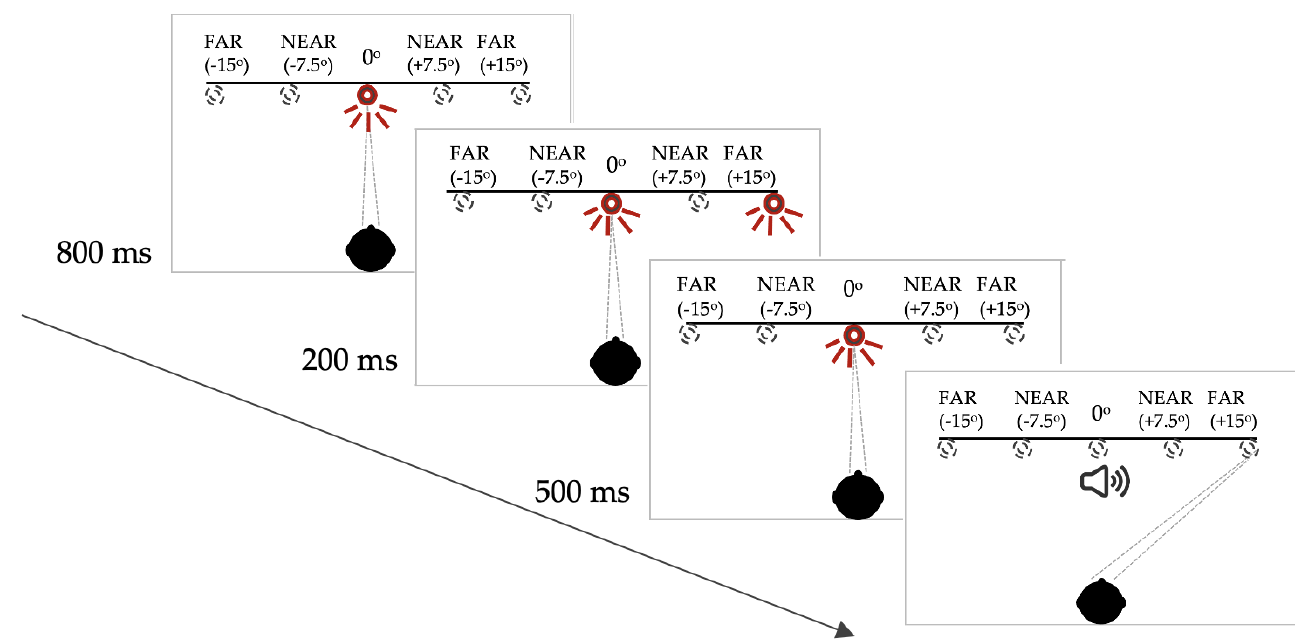
Figure 1. Saccadic target paradigm for the memory-guided saccade task. Note: the targets were only visible when lit up. See Supplementary Materials (S1) for full description of the target configuration and the subject instructions.